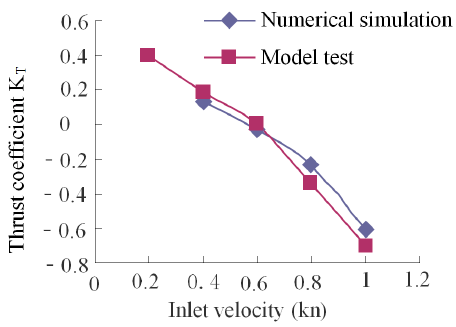
Figure 6. Rotation speed at 500 rpm.